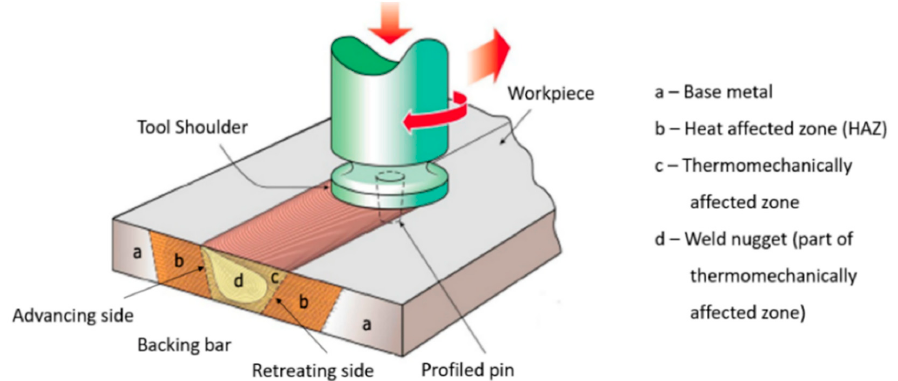
Figure 1. Schematic of the friction stir welding process.